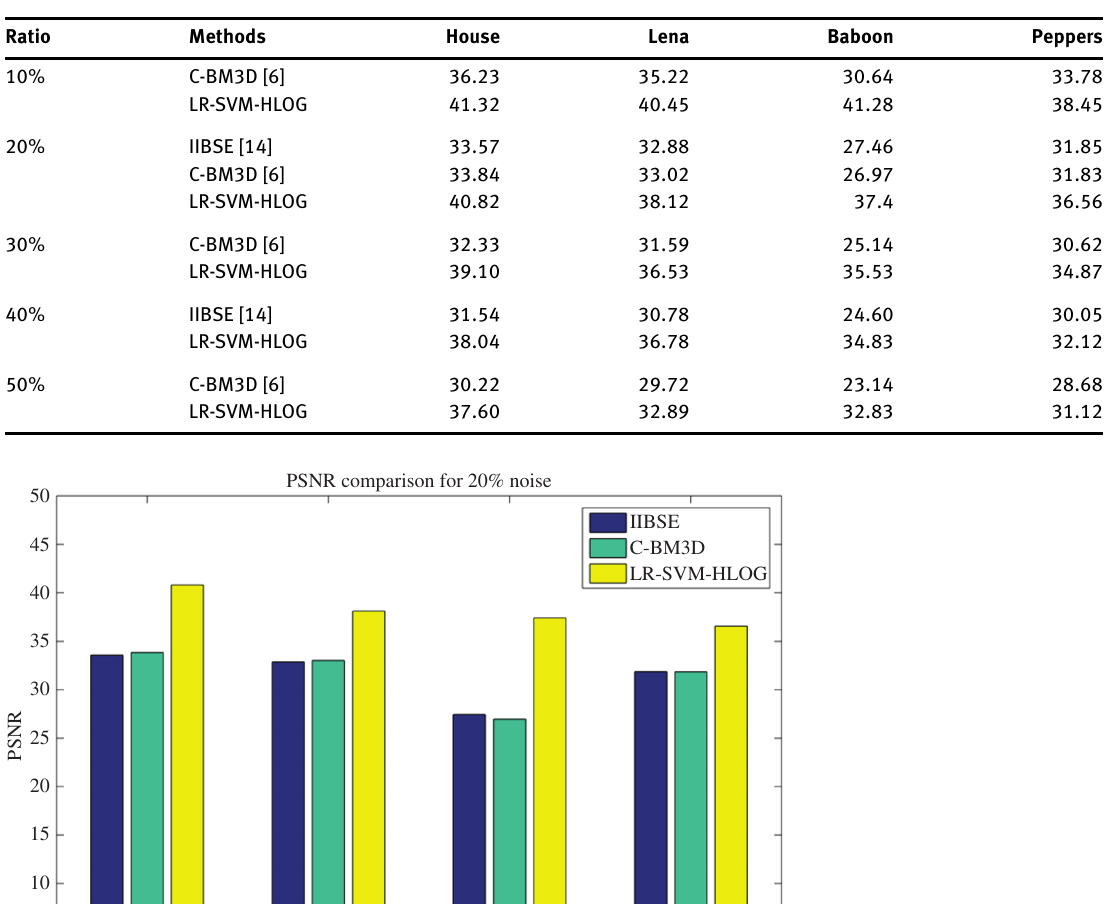
Table 5: Comparative Analysis for Color Images.